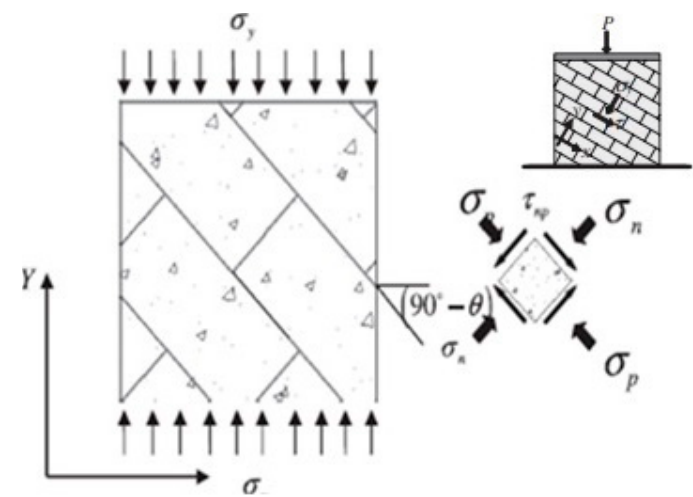
Figure 5. Masonry assemblage under combined shear and compression.